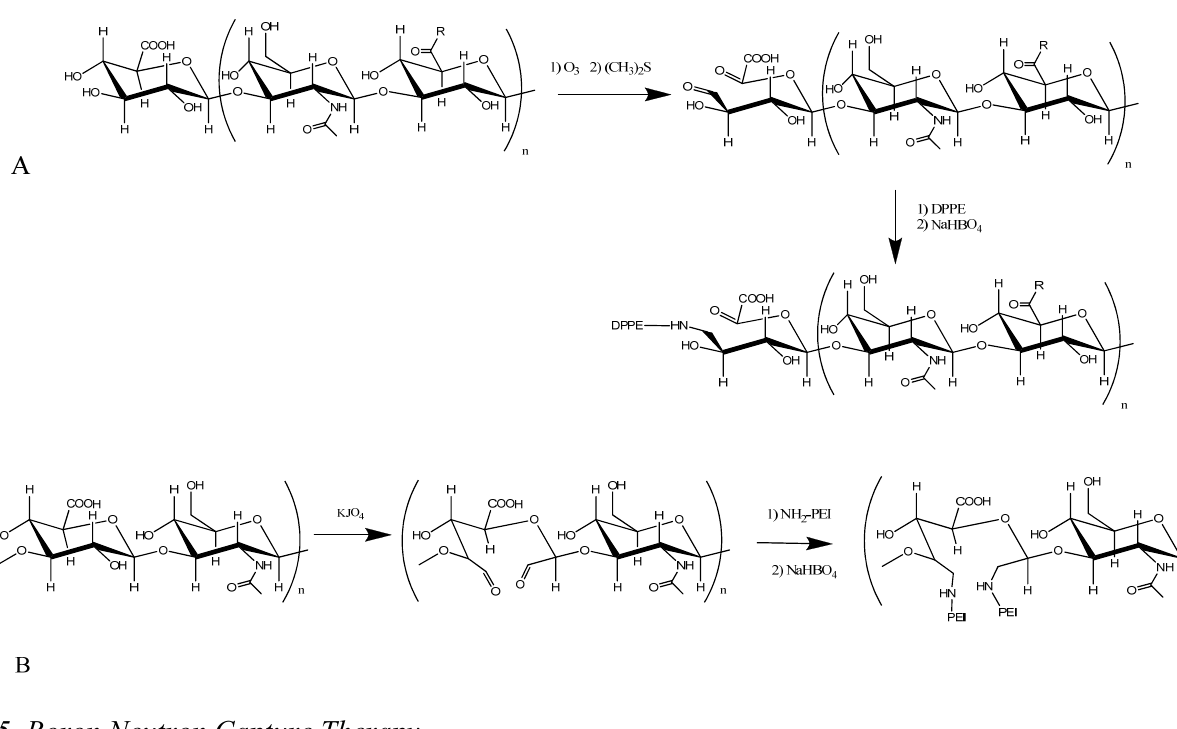
Figure 2. Synthetic scheme of hyaluronic acid-phospolipid- ( A ) and polyethyleneimine ( B